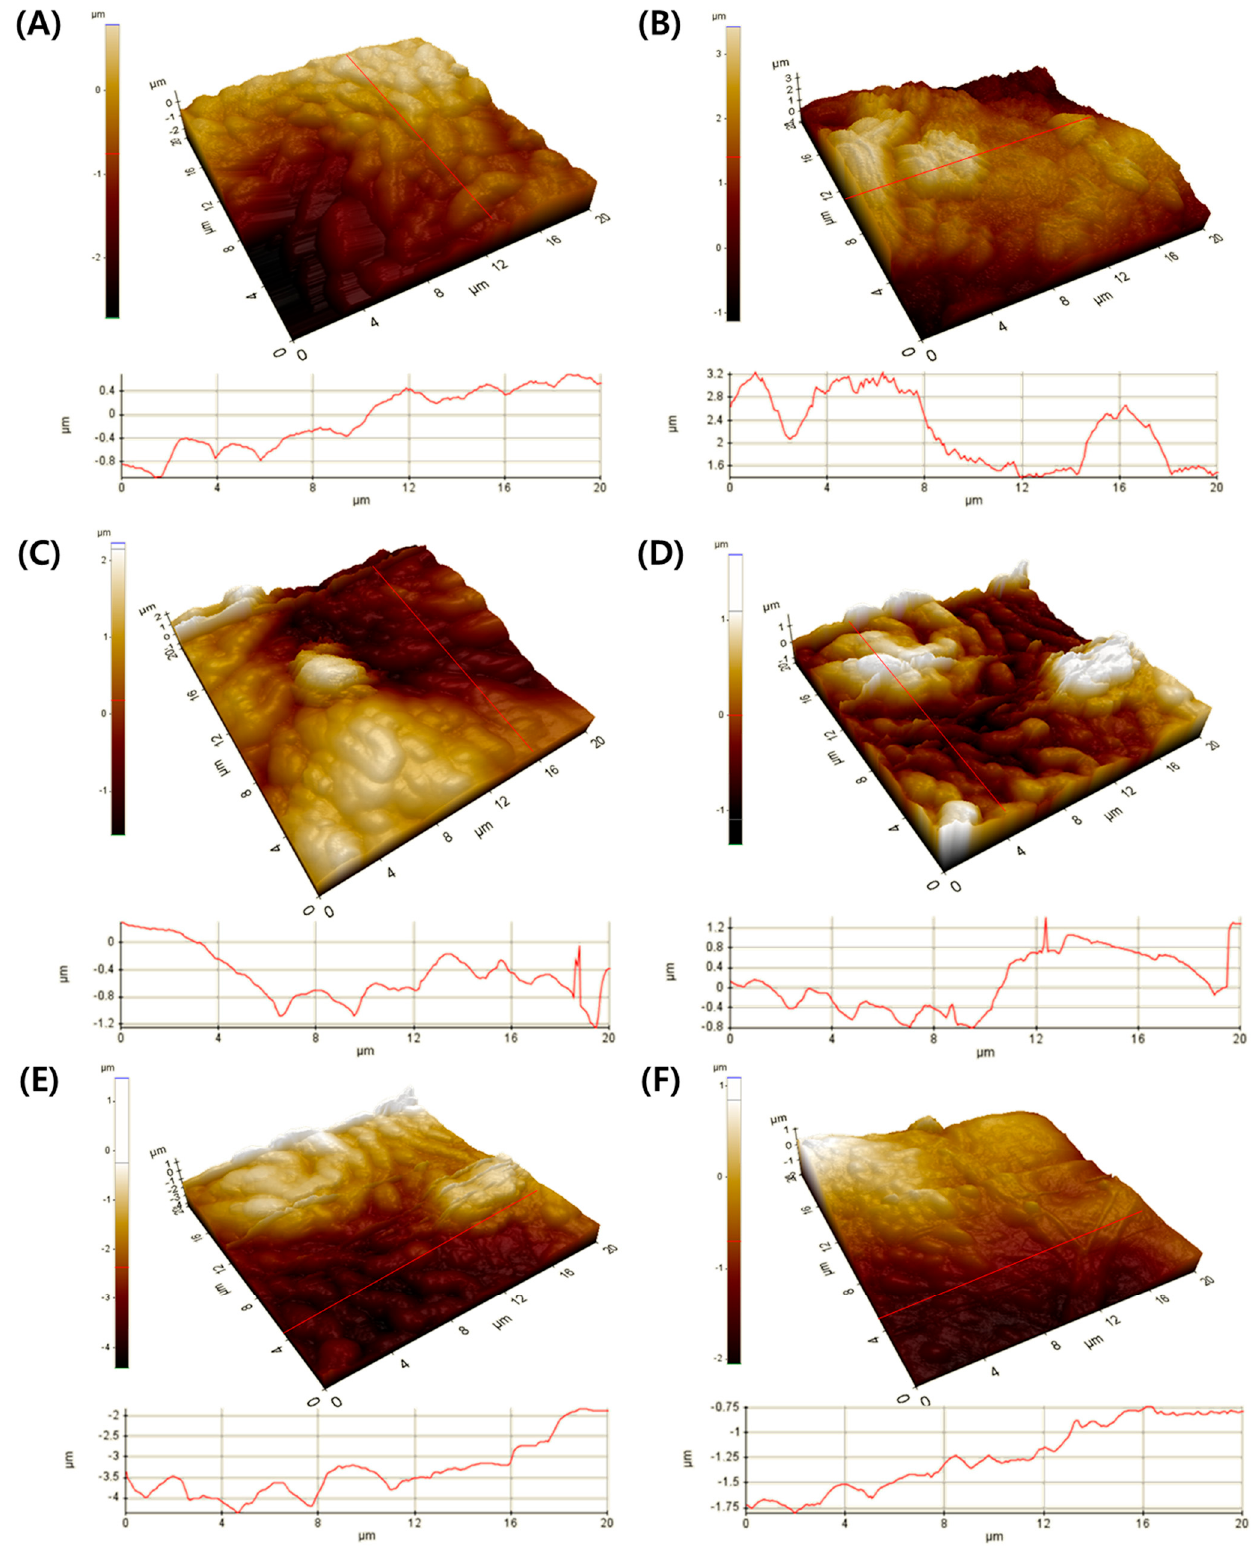
Figure 5. Atomic force microscopy characterization (surface height maps and 3D profiles) of adaxial surface of Ardisia japonica leaf under CL (continuous light) with ( A ) drought and ( B ) water supply, under LD cycle (light/dark cycle; 14 h/10 h) with ( C ) drought and ( D ) water supply, and under CD (continuous dark) with ( E ) drought and ( F ) water supply.